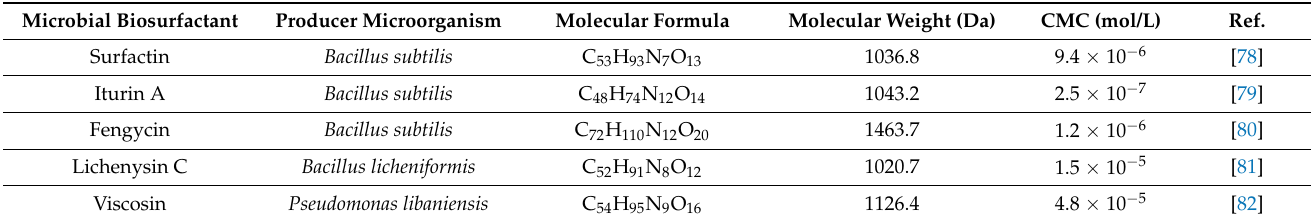
Table 1. Lipopeptide microbial biosurfactants. Microbial sources, molecular formula and weight and critical micellar concentration (CMC).